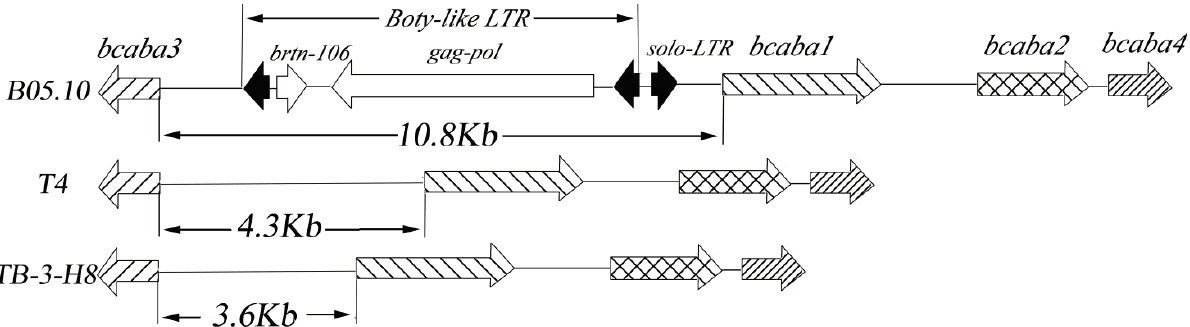
Figure 5. The structure of the ABA gene cluster in B . cinerea B05.10, T4 and